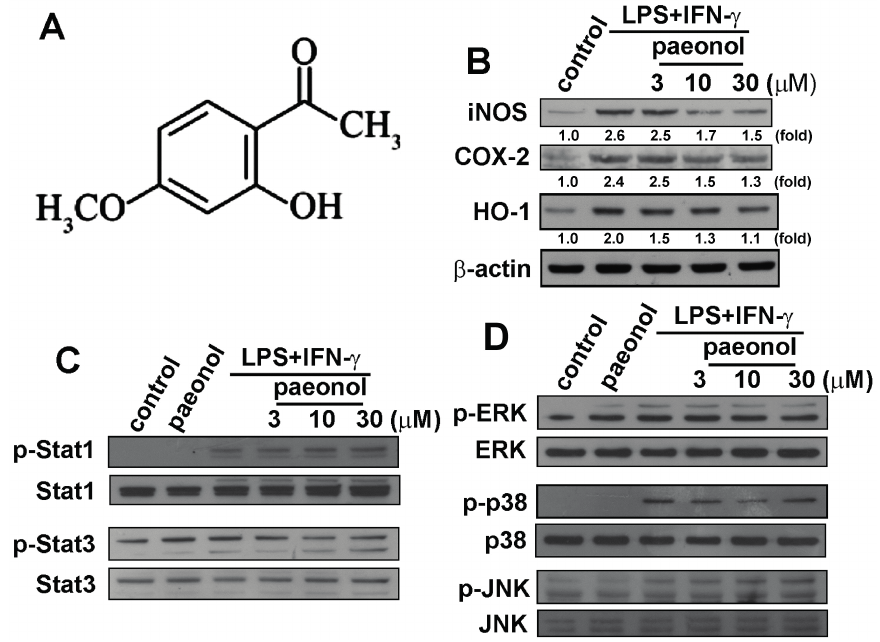
Figure 1. Effects of paeonol on inflammatory responses in BV-2 microglia. ( A ) The chemical structure of paeonol; ( B ) Cells were pretreated with various concentrations of paeonol (3, 10, or 30 μ M) for 30 min before stimulation with LPS (10 ng/mL)/IFN- γ (10 ng/mL) for another 24 h. Whole-cell lysates were subjected to western blot analysis for iNOS, COX-2 and HO-1; ( C , D ) Cells were pretreated with various concentrations of paeonol (3, 10, or 30 μ M) for 30 min before stimulation with LPS (10 ng/mL)/IFN- γ (10 ng/mL) for 90 min. Whole-cell lysates were subjected to western blot analysis using antibodies against the phosphorylated Stat1 and Stat3 ( B ), ERK1/2, p38 and JNK ( C ). Similar results